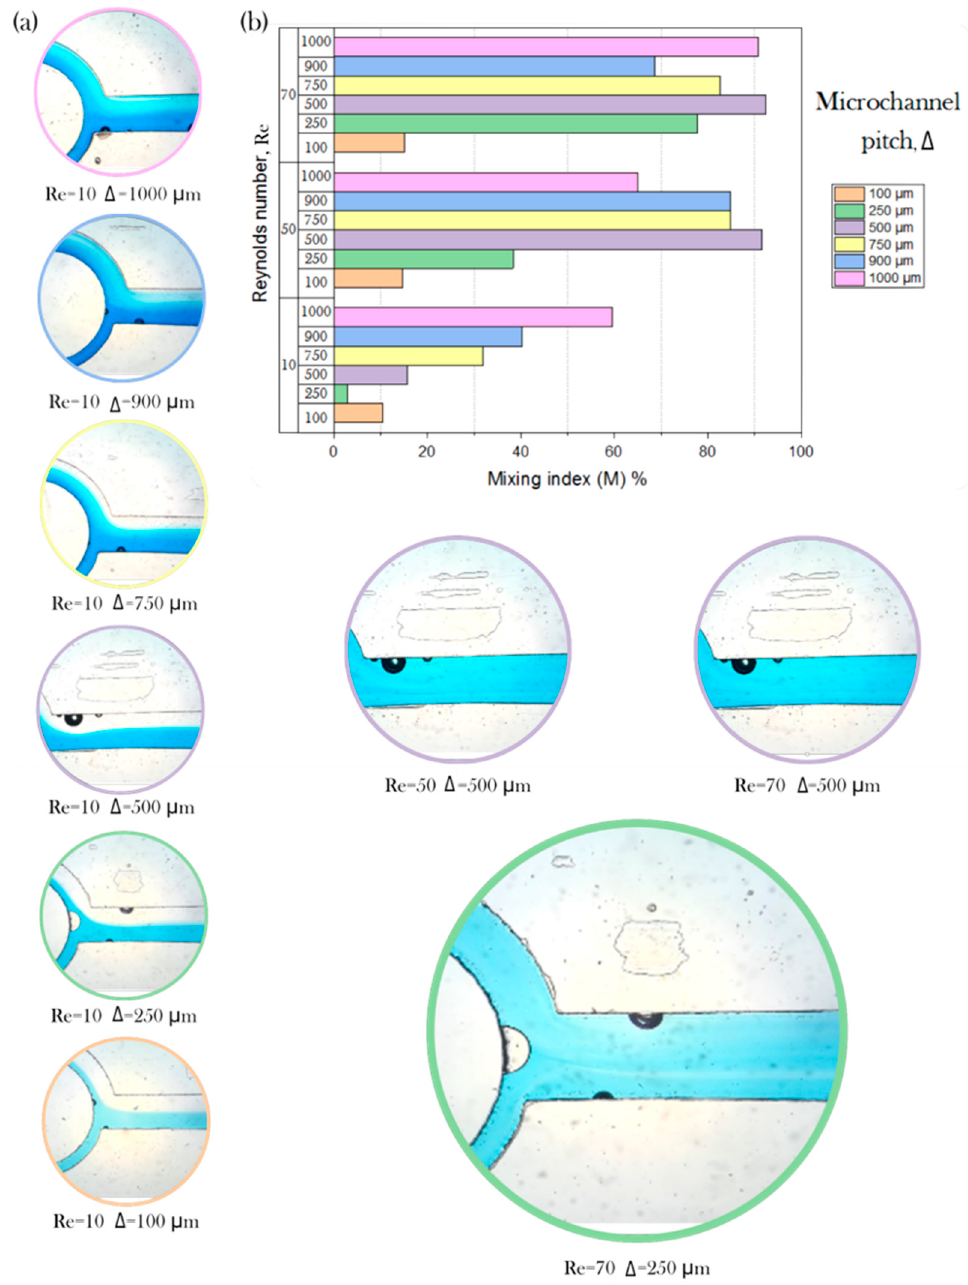
Figure 8. Case study; ( a ) Channel depth assessment comparison using the calculated mixing indexes in a range of 10 < Re < 70; and ( b ) Mixing index M vs Reynolds number vs microchannel pitch ( Δ ).